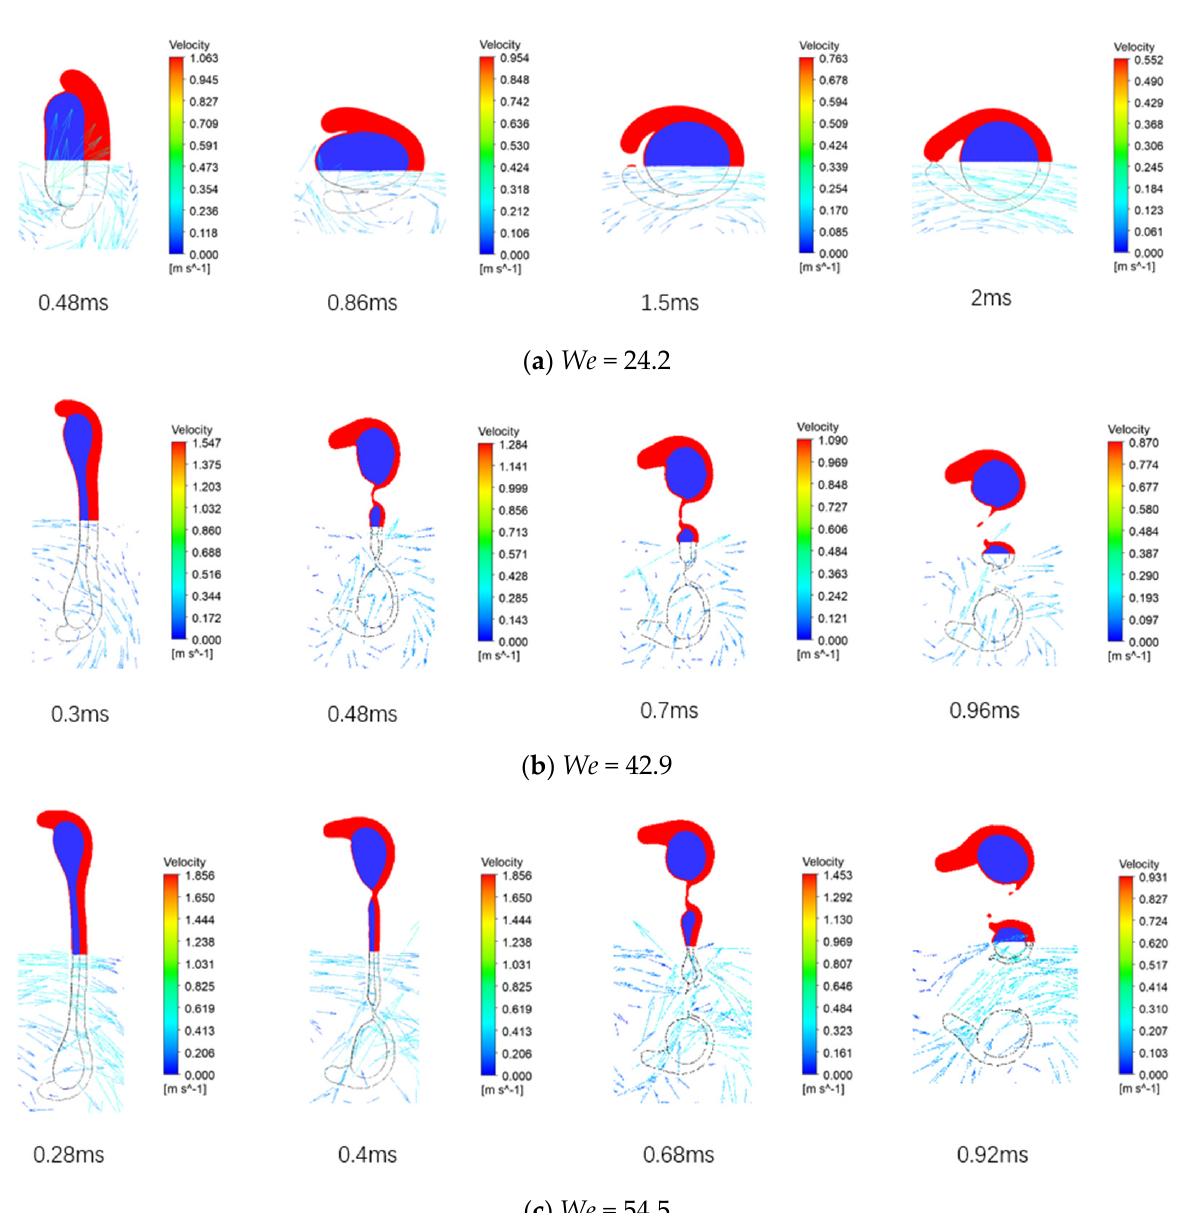
Figure 5. The simulated velocity fields evolve with time.